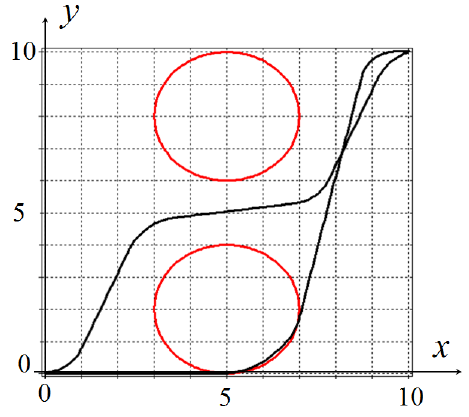
Figure 1. Trajectories of movement of robots.